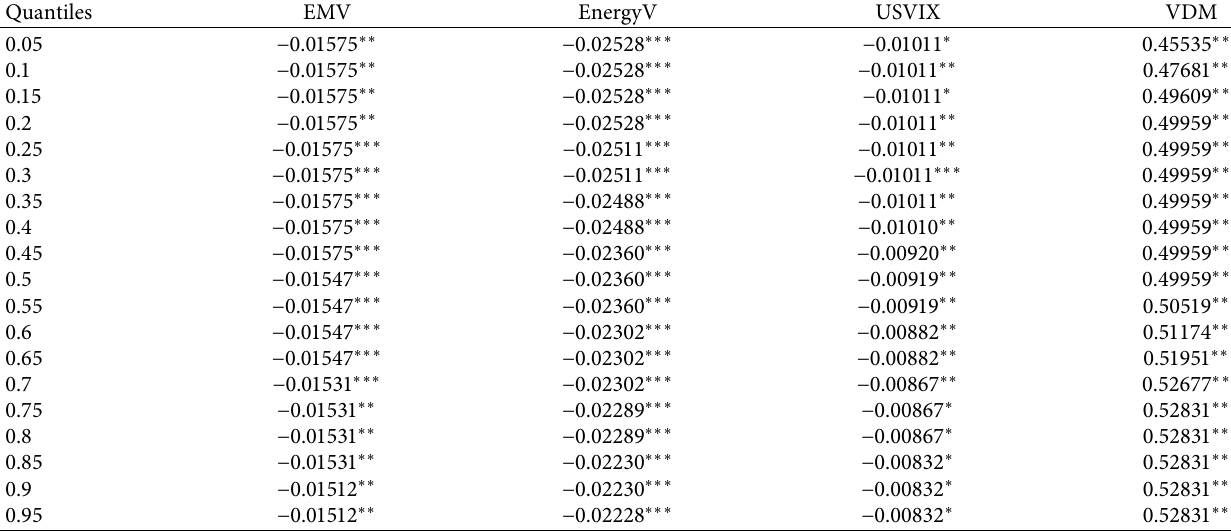
Table 3: Effect of volatilities on DJIMAPDI.